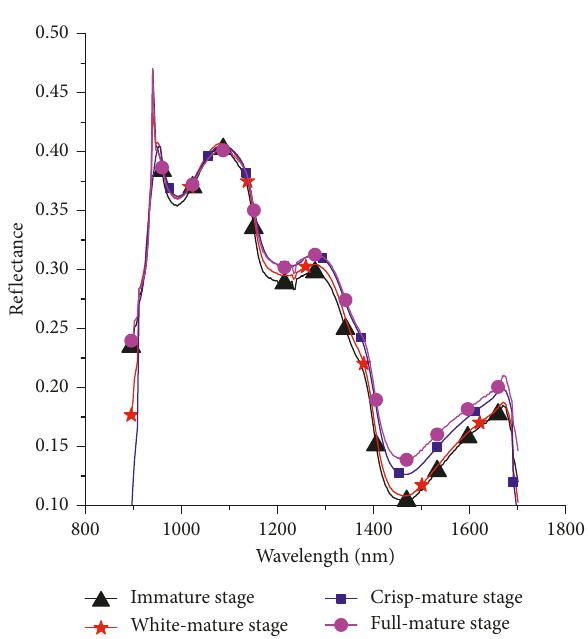
Figure 2: Average spectral curves of the runs, the minimum values of MSE were all around 1.42% 2 , the obtained optimal parameter values and the number of iterations at the time of convergence were respectively similar, which indicated that the method had good ro- bustness. In the third run, the MSE converged to 1.42% 2 at the 11th iteration; the optimal values of c and σ 2 were, respectively, 5.00 × 10 4 and 49.52. The GS-LS-SVM and ABC-LS-SVM were used to build models, respectively. The results are displayed in Table 3. The Rp 2 , RMSEP, and RPD for the prediction set using GS-LS- SVM model were 0.98, 1.24%, and 6.96, respectively.